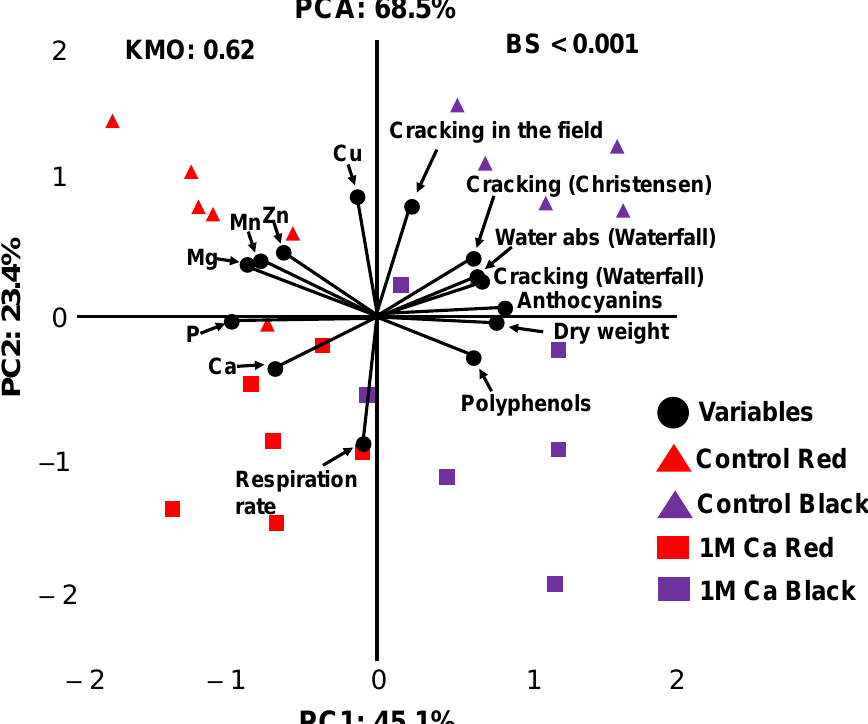
Figure 3. Principal component analysis (PCA) of high-dose calcium (1M CaCl 2 ) treatment compared to control and red to black skin cherries at harvest. The indicators are Kaiser–Meyer–Olkin (KMO) measure of sampling adequacy and Bartlett’s test of sphericity (BS). Control is depicted as triangle and 1M CaCl 2 treatment as square, red skin cherries are depicted in red colour and black skin cherries in purple colour. Variables represented as black circle.